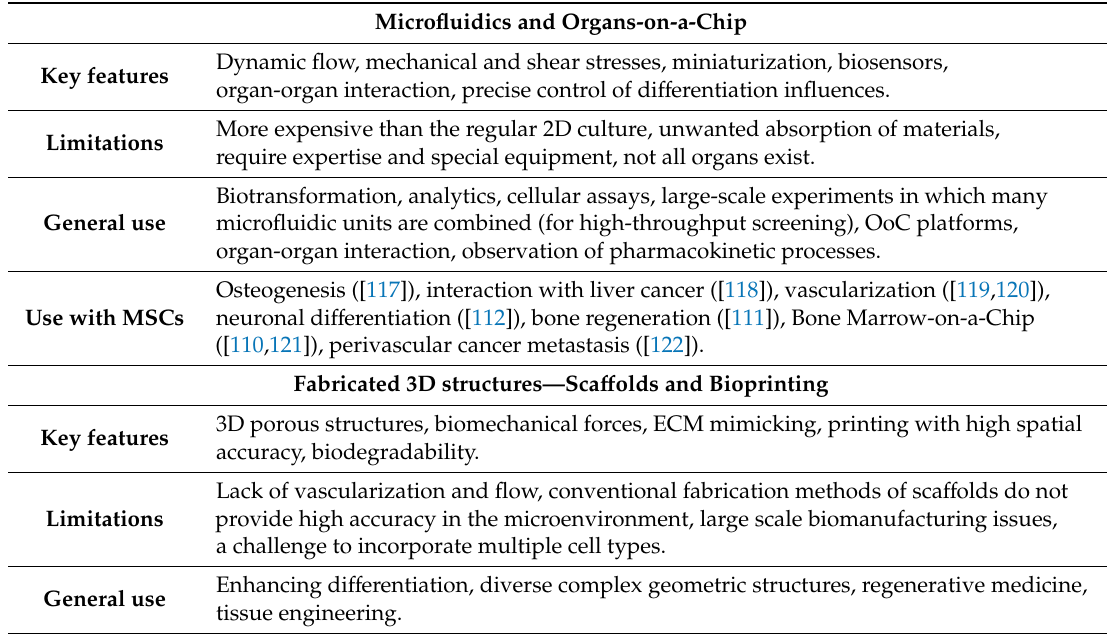
Table 3. Novel in vitro